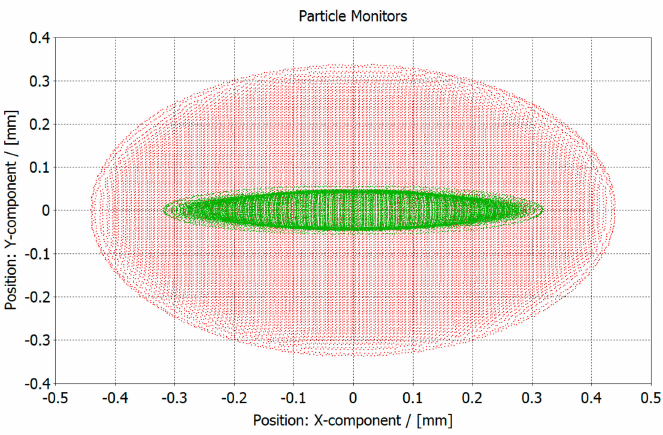
Figure 4. Compression of the sheet beam from emission surface to the waist.